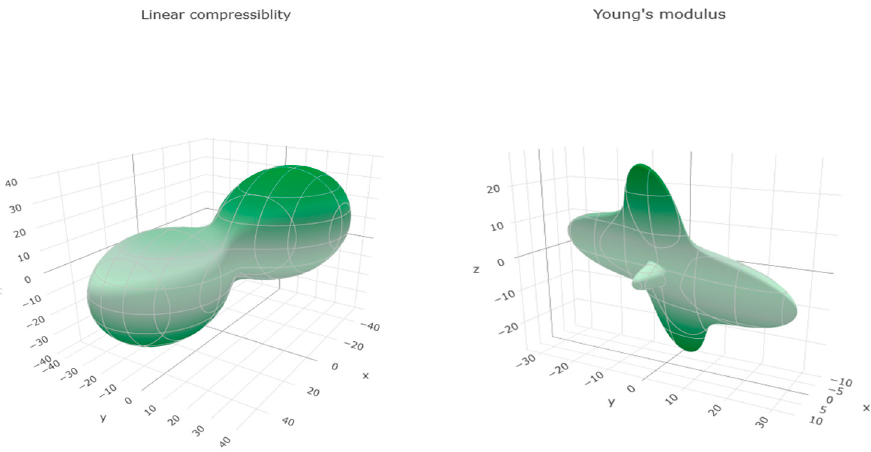
Table 4. Calculated mechanical properties of ENT-THP-water cocrystal. Figure 13. Spatial distribution of linear compressibility and Young modulus of ENT-THP-water co- crystal, using the ELATE visualization